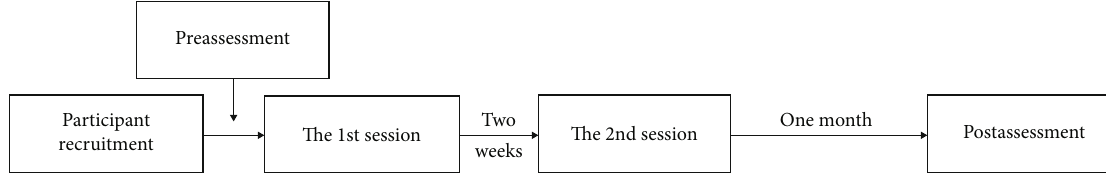
Figure 1: The study design of educational intervention for the parents of CD